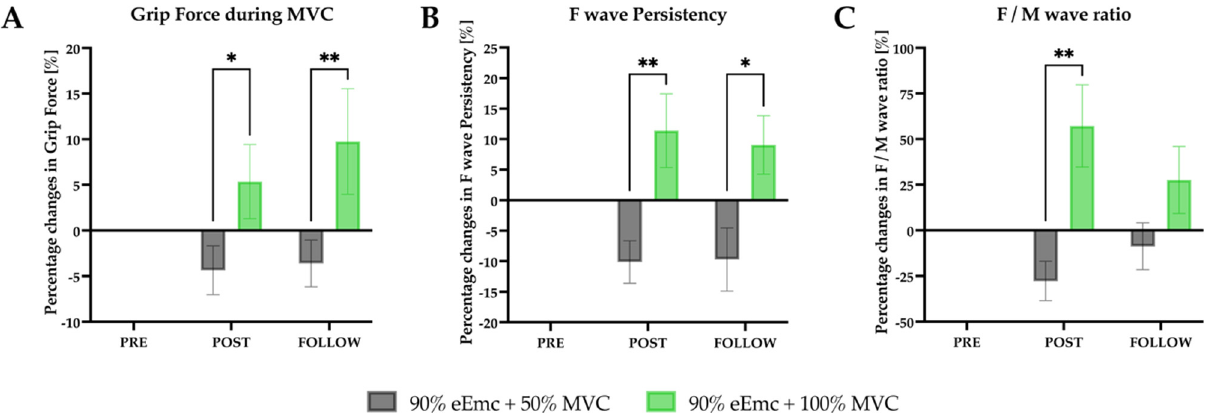
Figure 5. Changes in MVC, F wave persistency and F/M wave ratio. ( A ) percentage changes in grip force during MVC according to baseline. Intervention simple effect showed differences at post (* p = 0.0144) and follow (** p = 0.0011); ( B ) percentage changes in F wave persistency according to baseline. Intervention simple effects showed significant differences at post (** p = 0.0073) and follow (* p = 0.0191); ( C ) percentage changes in F/M ratio according to baseline. Intervention simple effect showed significant differences at post (** p = 0.0016).